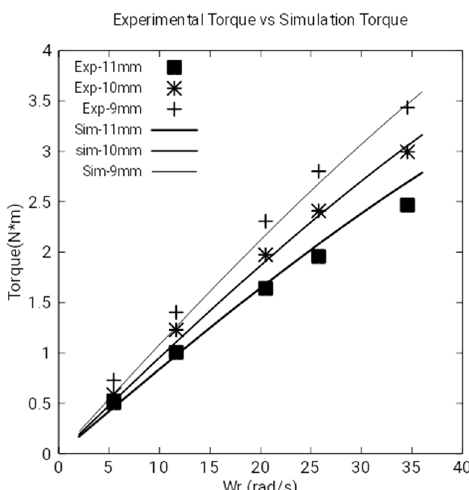
Figure 12. Experimental and simulated results of the electromagnetic torque in the disk.